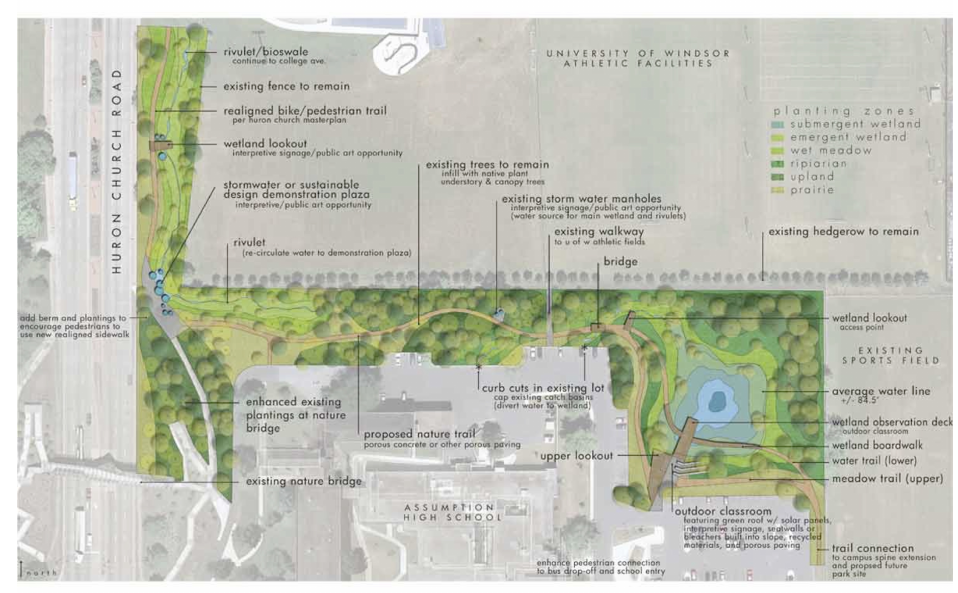
Figure 3: Noel Harding, Rod Strickland, Dawn Danby, Justin Langlois, Stantec Consulting, and LandLab Environmental Design, Urban Wetland Site Plan for The Green Corridor Project, c. 2006. Image courtesy of LandLab Environmental